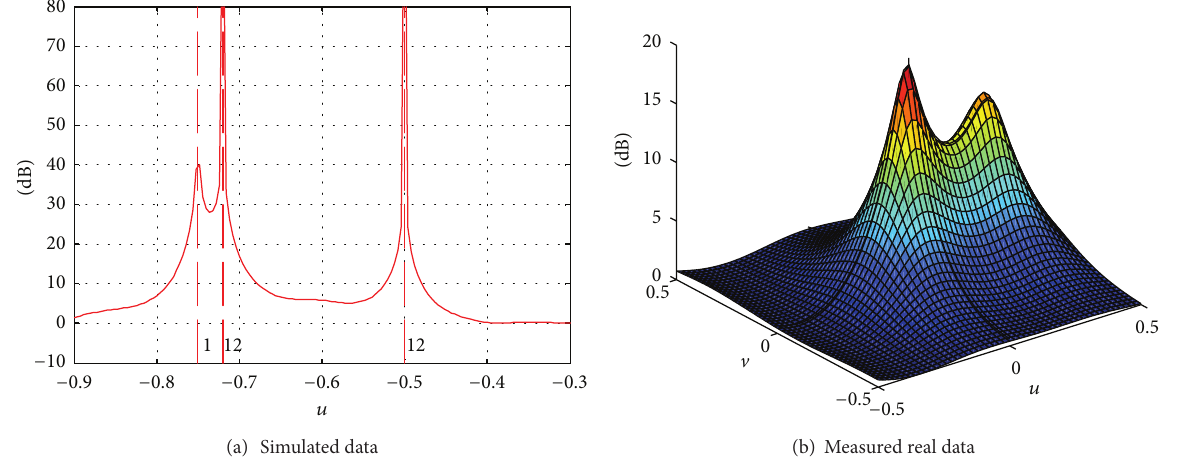
Figure 9: MUSIC spectra with a planar array of 7